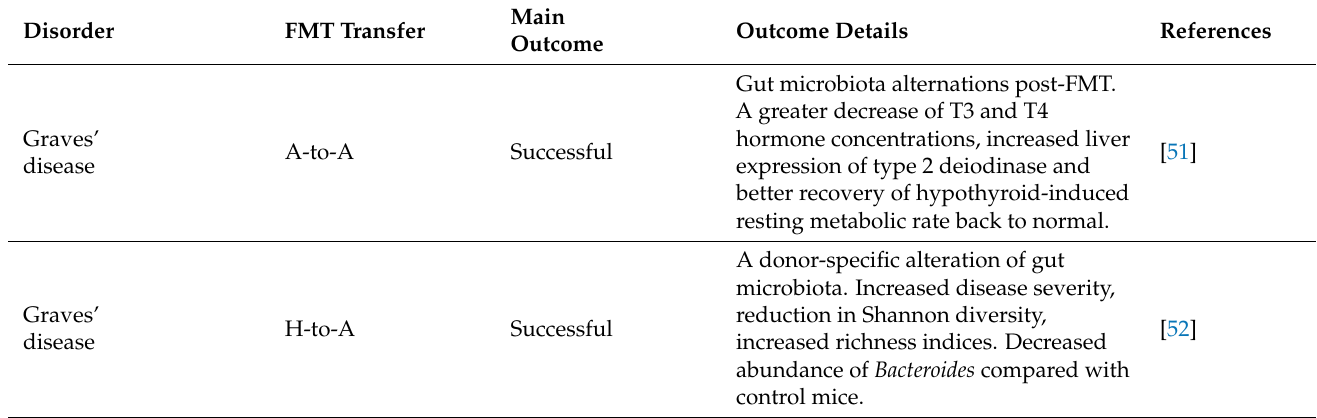
Table 4. Pathologic state-inducing experimental studies applying FMT in autoimmune diseases. induce the pathologic states of autoimmune diseases in animal models, namely Grave’s disease, Hashimoto ´ s disease, rheumatoid arthritis, Sjogren’s syndrome, type I diabetes and systemic lupus interesting outcome results. Transplantation from human donor into animal model recipient